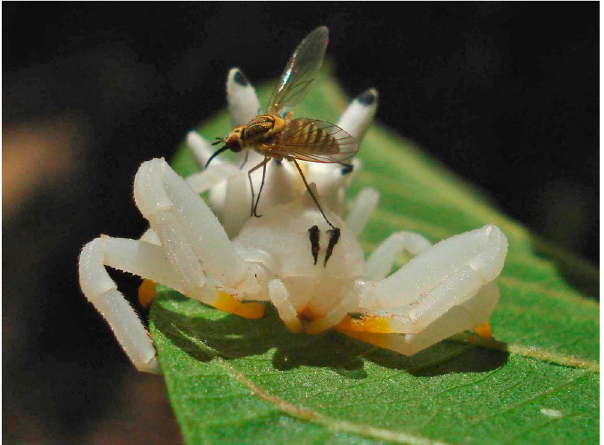
Figure 1. Interaction between the crab spider and a pollinator. Adult Epicadus heterogaster female being visited by a Xylophagidae fly upon a leaf (photo credit: Piccoli,